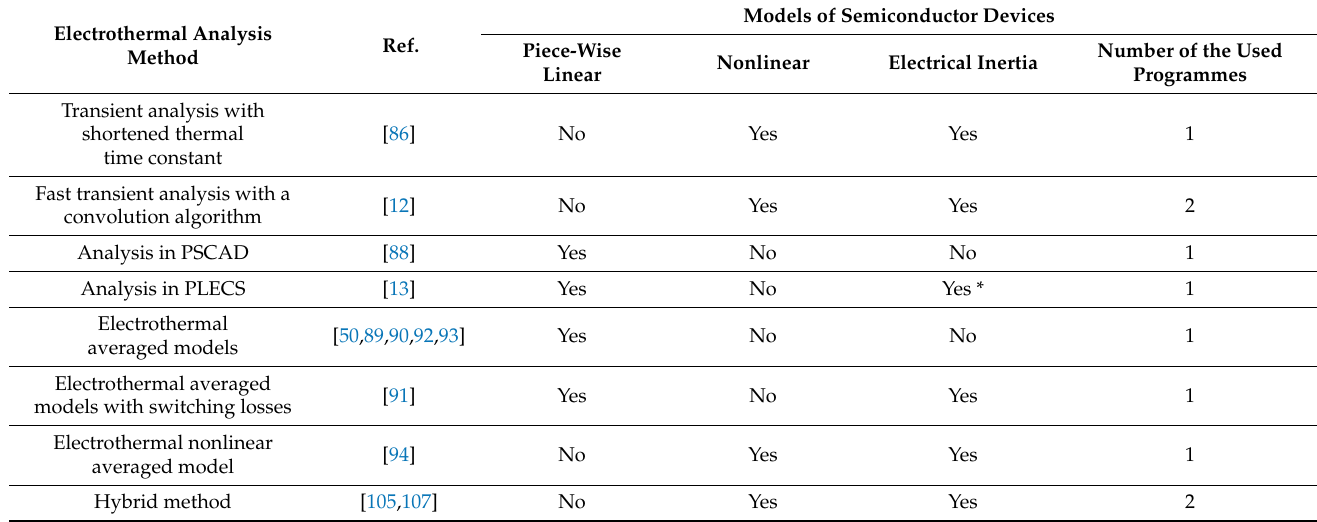
Table 3. Properties of fast electrothermal analyses.